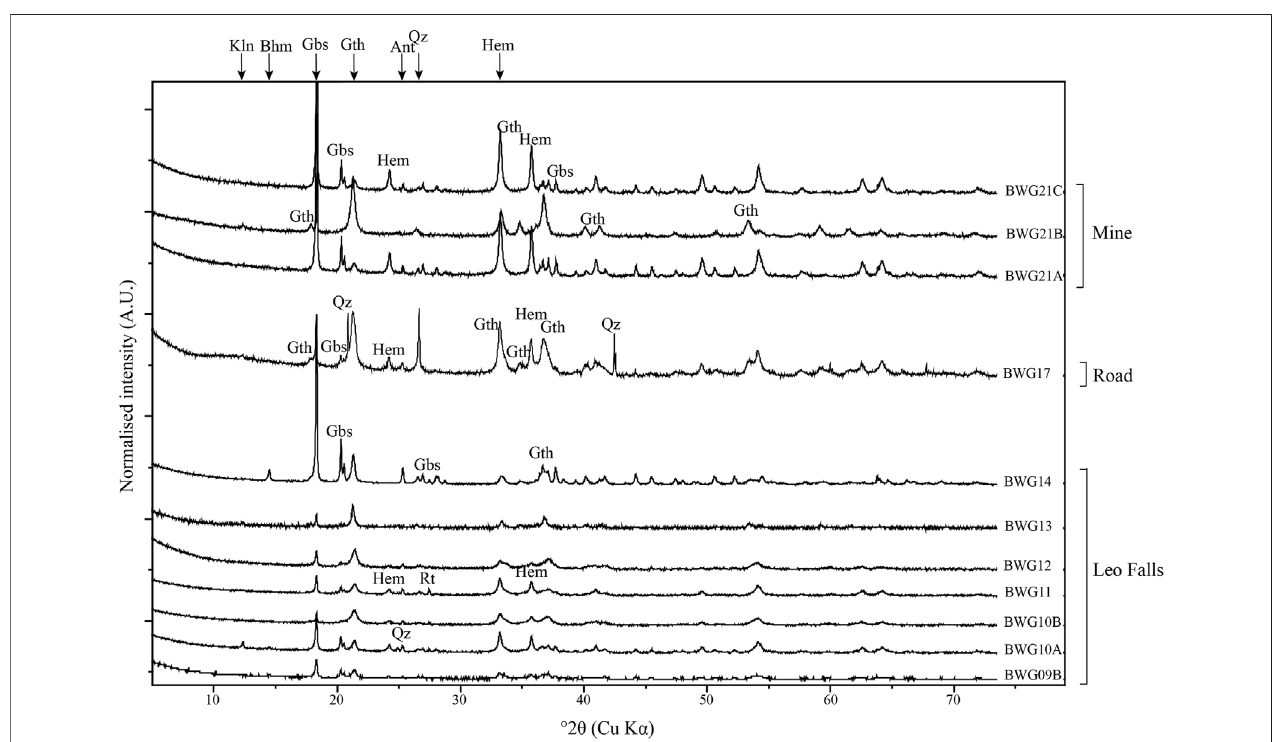
FIGURE 4 | XRD pattern of duricrust samples from each site. With Ant, anatase; Bhm, boehmite; Gbs, gibbsite; Gth, goethite; Hem, hematite; Kln, kaolinite; Qz, quartz; Rt, rutile.